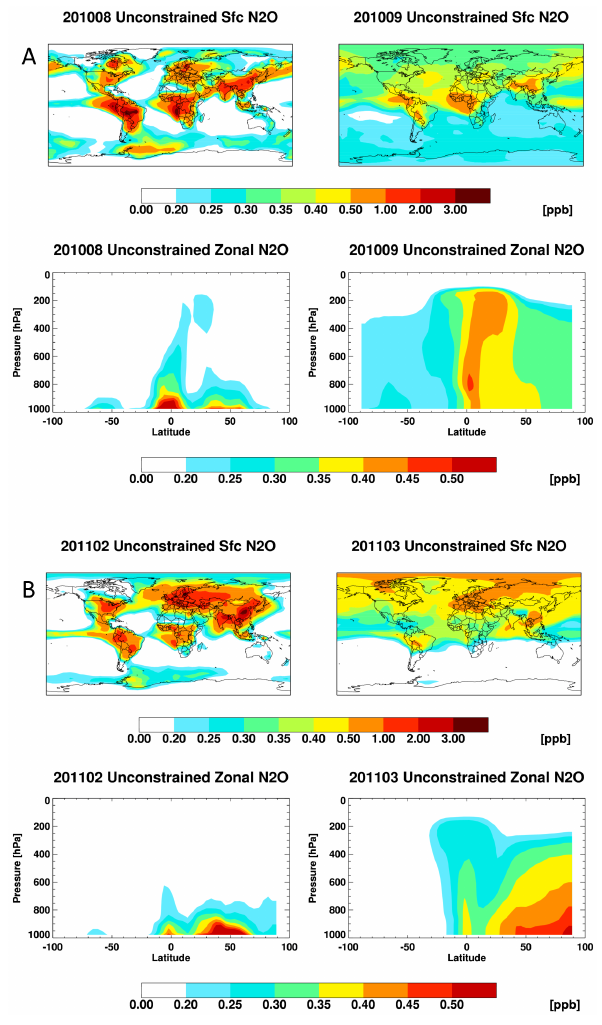
Figure 12. Distribution of unconstrained N 2 O simulated by GEOS- Chem during the month of emission ( (a) August 2010 and (b) February 2011) and the subsequent month. Unconstrained concen- trations are calculated by scaling emissions for a particular month by (1 − x ), where x is the map of emission error reductions achieved using surface observations of N 2 O. The initial atmospheric burden of N 2 O and the emissions in the ensuing months are set to zero in order to highlight the spatial dispersal of unconstrained N 2 O. Note nonlinear color